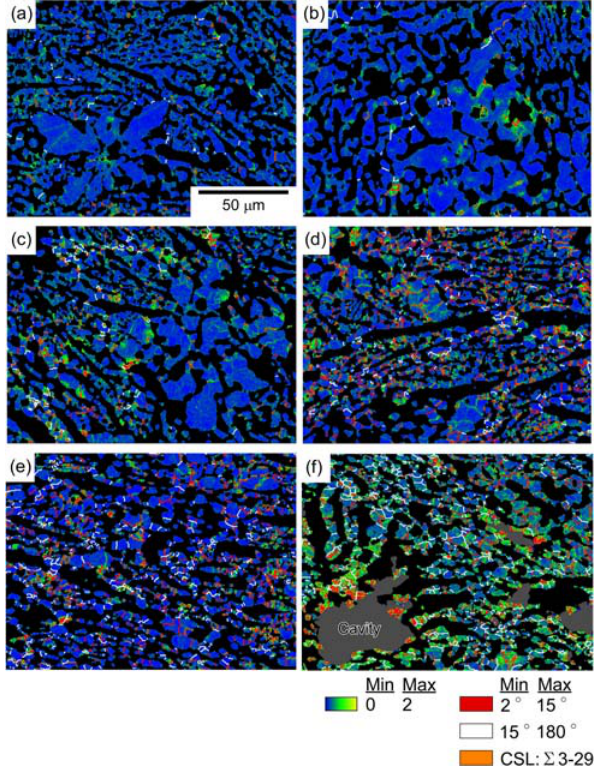
Figure 7: KAM maps with grain boundary characters of Mo ss in the MoSiBTiC alloy crept at 1,500°C and 137 MPa with creep stains of ( a ) 0%, ( b ) 3%, ( c ) 12%, ( d ) 32%, ( e ) 53%, and ( f )